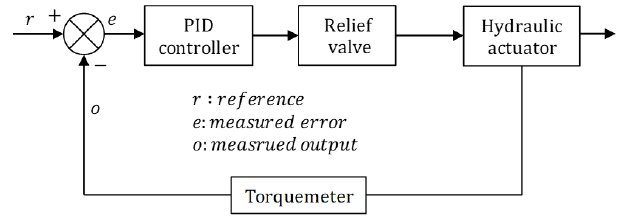
Figure 11. Feedback control system for torque control.